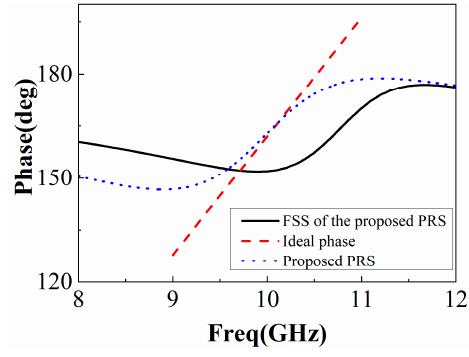
Figure 6. PRS reflection phase diagram.